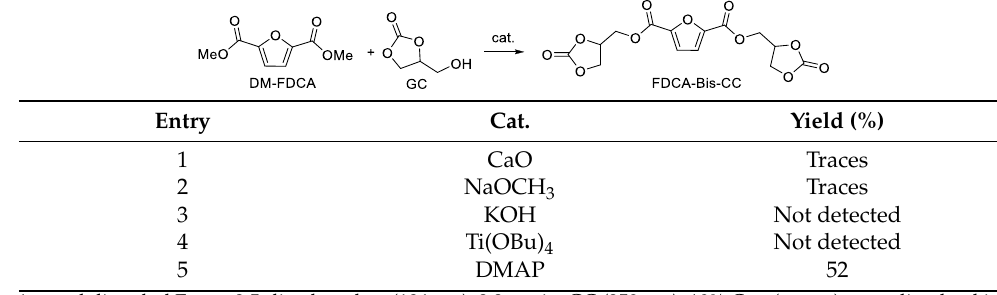
Table 1. Catalysts screening for the transesterification reaction.